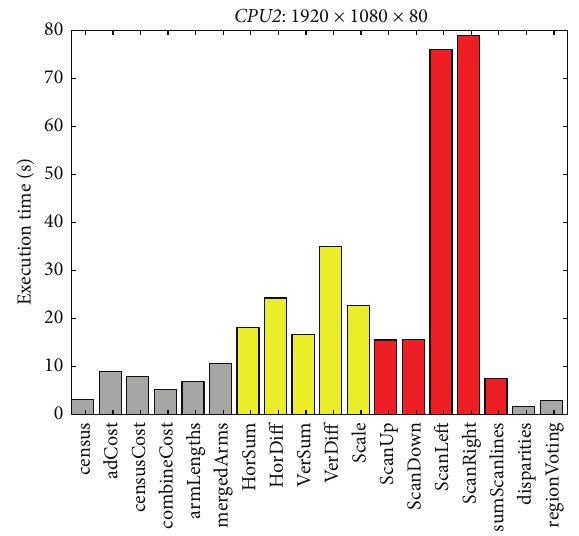
Figure 6: Runtimes that different kernels contribute to overall runtime on Convey CPU (denoted by CPU2) for a FullHD image pair.Yellowandredbarsindicatekernelsinaggregationandscanline phase,